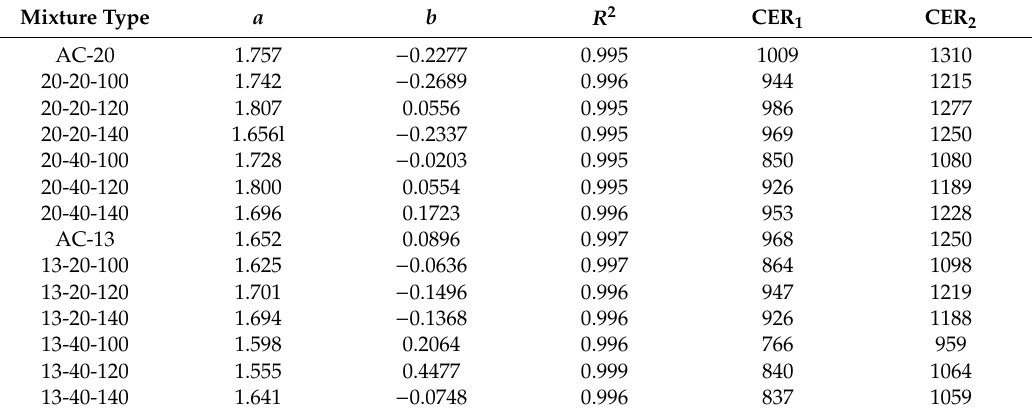
Table 9. Regression results of Equation (4) and the compaction energy ratio